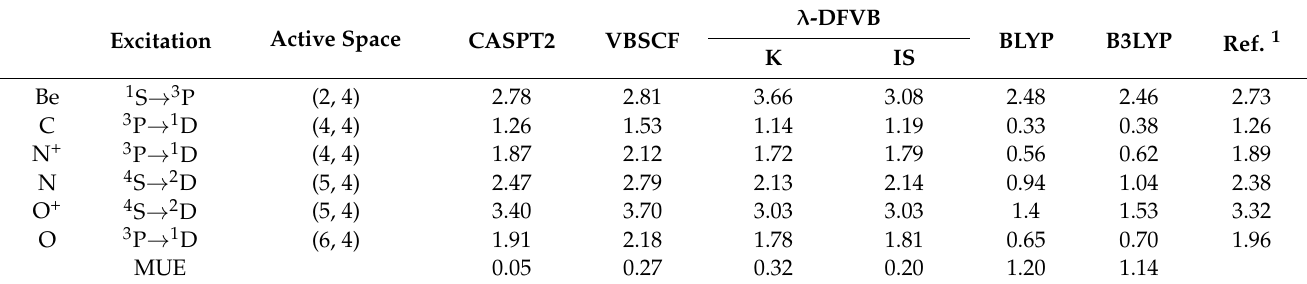
Table 4. The excitation energies (in eV) of several atoms in the second row. Excitation Active